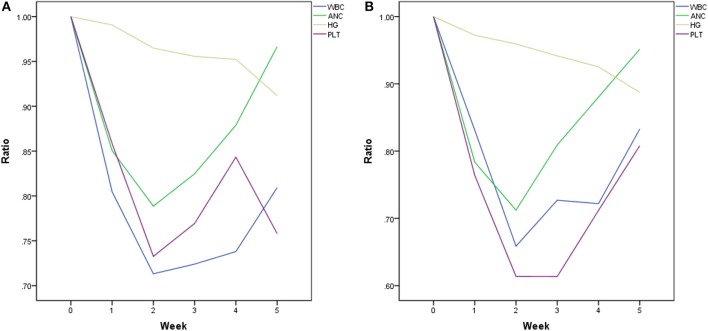
Trend of blood cell count ratio (mean): (A) 5FU group; (B) FOLFOX group.